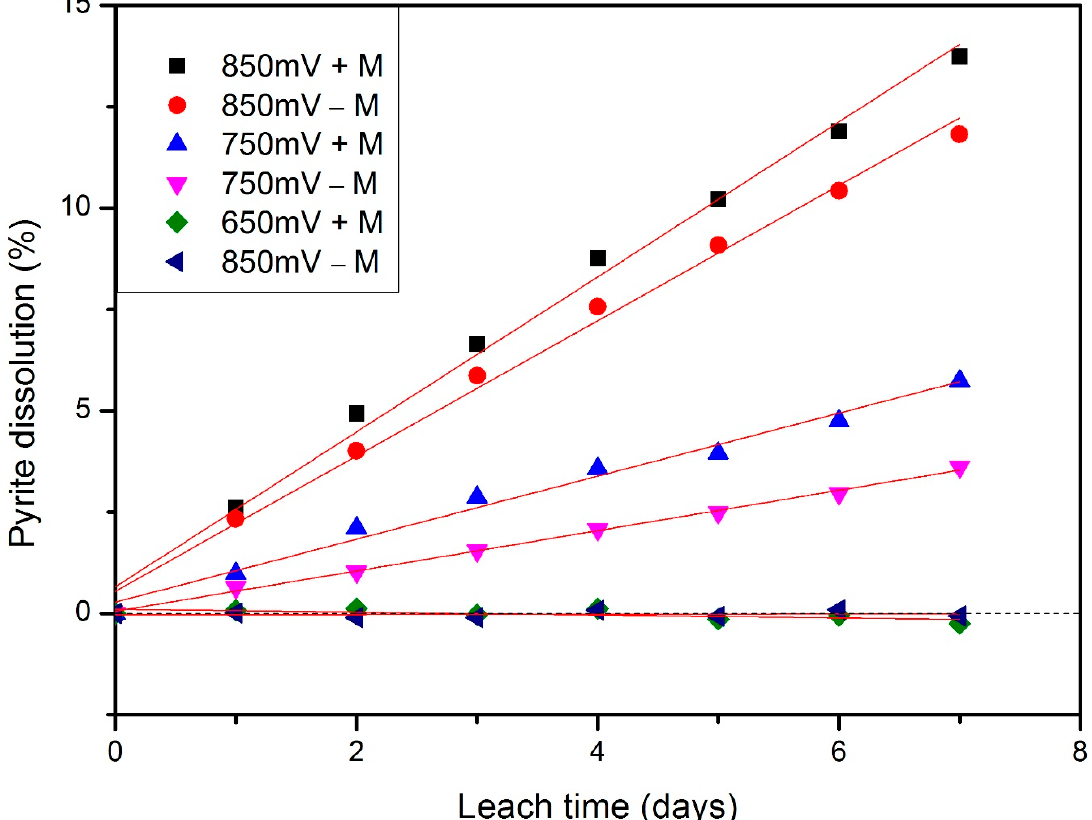
Figure 4. Effects of attached microbes on pyrite oxidation rate under different redox potentials. 850 mV + M: pyrite leaching with attached microbes under 850 mV; 850 mV − M: pyrite leaching without attached microbes under 850 mV; 750 mV + M: pyrite leaching with attached microbes under 750 mV; 750 mV − M: pyrite leaching without attached microbes under 750 mV; 650 mV + M: pyrite leaching